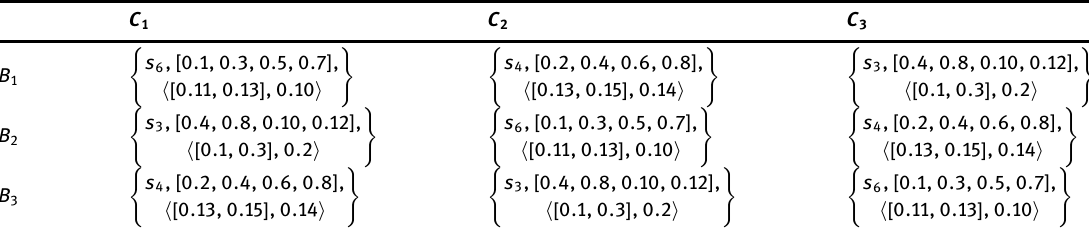
Table 2: Linguistic Variables of Ratings of Alternatives by Decision Maker. C 1 C 2 C 3